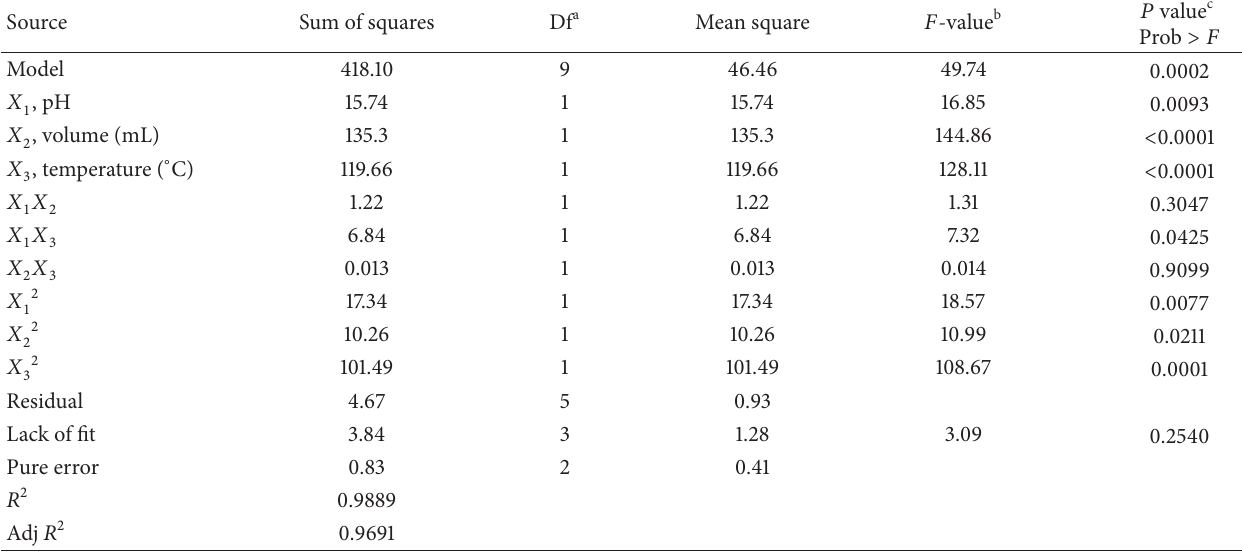
Table 3: Analysis of variance of the response surface quadratic model.